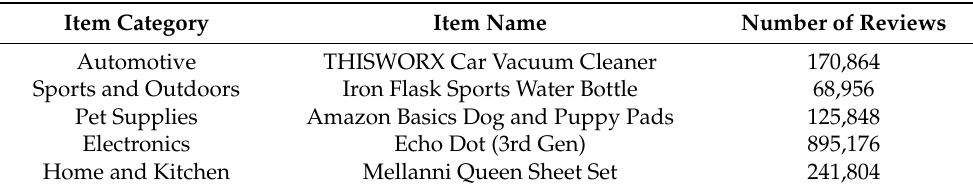
Table 1. Number of reviews received by Amazon Best Sellers